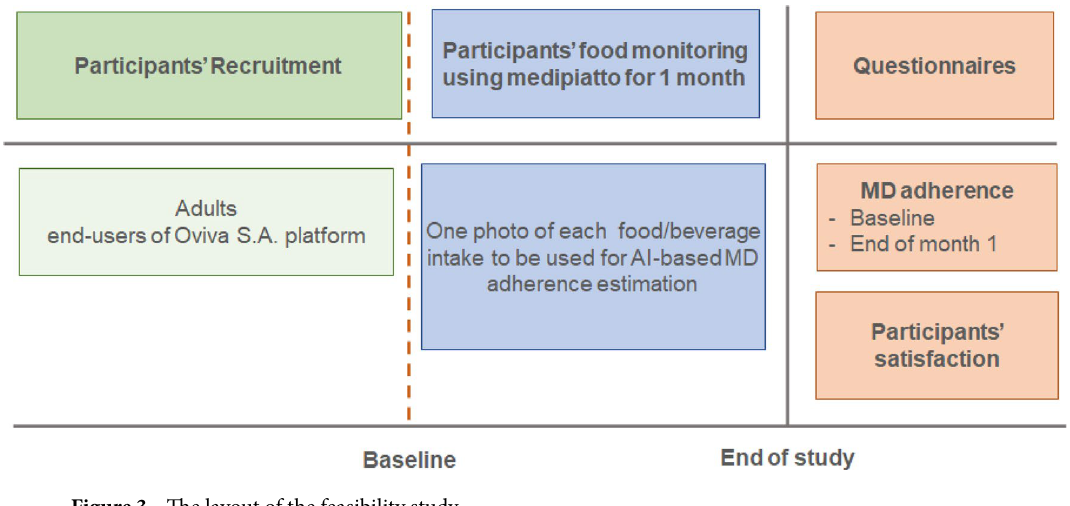
Figure 3. The layout of the feasibility